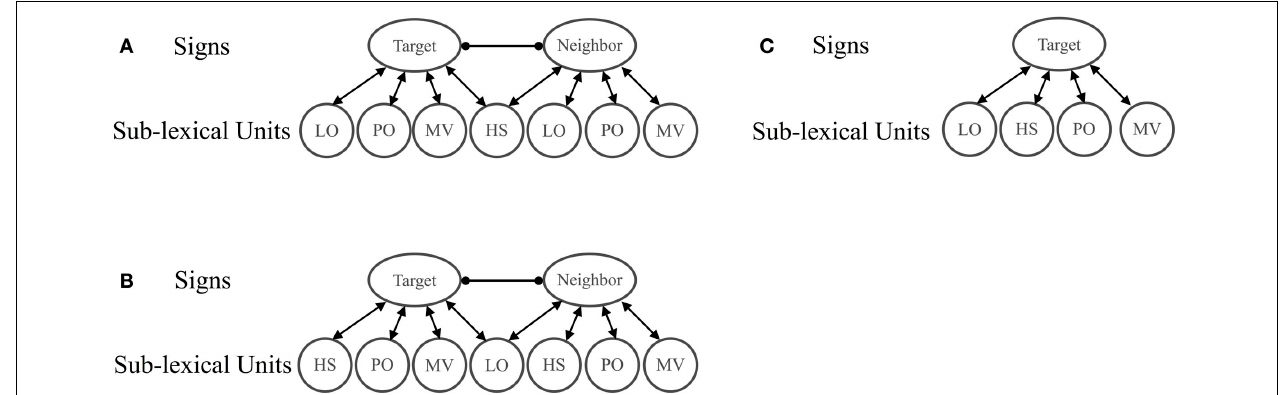
FIGURE 2 | Model Architecture. Activation of the target with a handshape neighbor (A) or location neighbor (B) was compared to activation of the target without a neighbor (C) . Neighbors were considered to have a facilitatory effect on sign recognition if the target item with a neighbor